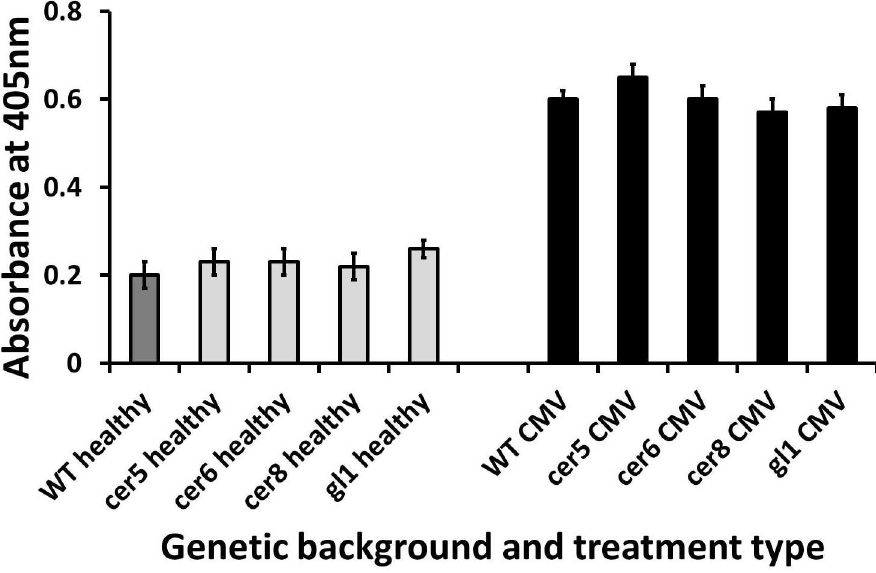
Fig 5. ELISA absorbance values from CMV-infected rosette leaves of cer5 , cer6 , cer8 and gl1 mutants (light grey bars) in comparison to L er WT leaves (dark grey bar) at 14 days post-inoculation. Results from healthy control leaves are also shown (black bars). Error bars denote standarderrors of the